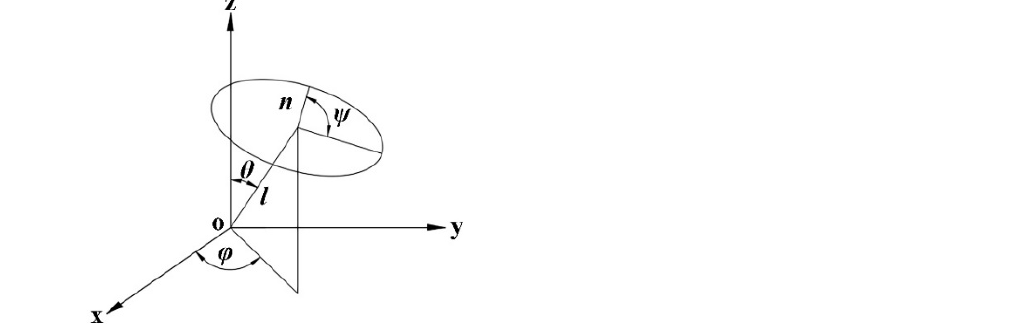
Figure 4. Spherical coordinate diagrams of shear moduli G with respect to perpendicular vectors, l and n .